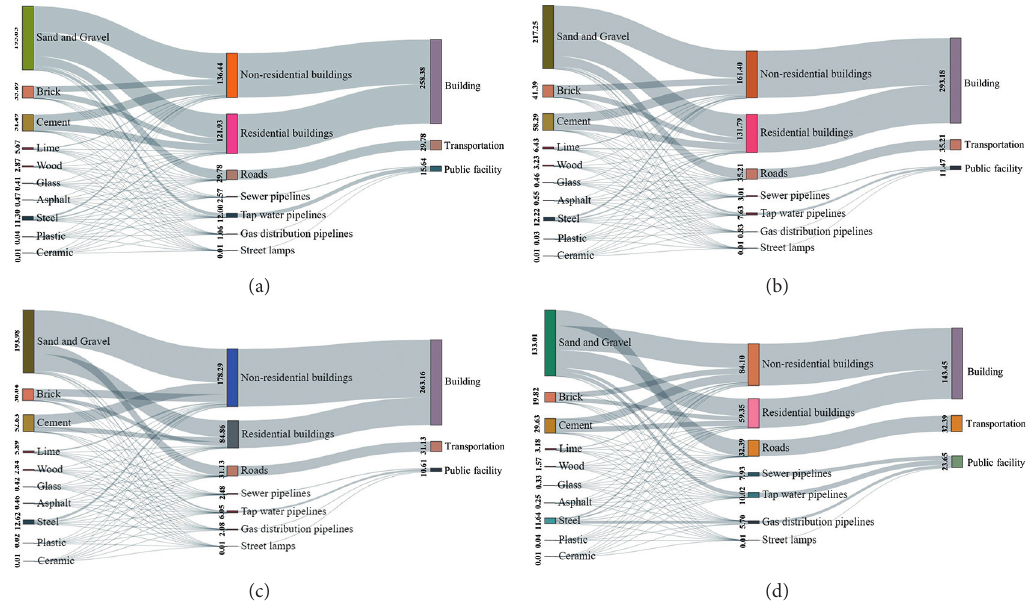
Figure 4: Distribution of construction material consumption across infrastructure types in 34 cities in Northeast China in 2010, 2012, 2015, and 2017. Note: the width of the streamline represents the amount of material consumption. (a) Year of 2010. (b) Year of 2012. (c) Year of 2015. (d) Year of 2017. The units in the figure are million